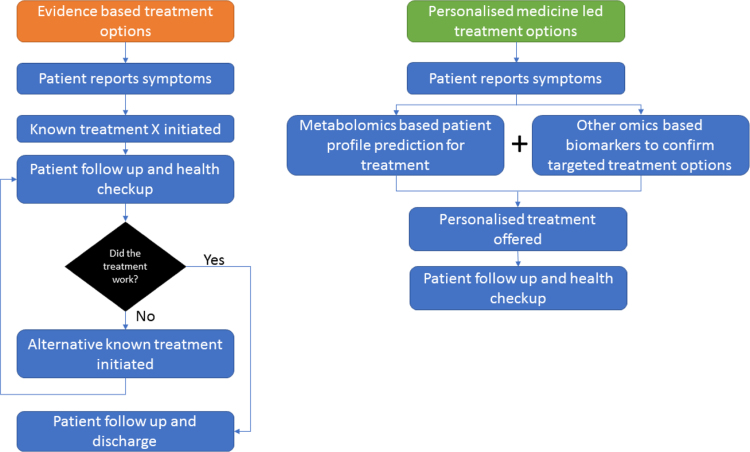
Flow diagram illustrating personalised medicine and highlighting the differences between Evidence-based versus Precision medicine-based approaches to disease treatment. As is clear the evidence-based approach is imprecise as it relies on the patient reporting progress to therapy. By contrast, precision medicine necessitates analytical measurements on the patient – typically from genetics (viz. SNPs) and metabolomics–and then using these to direct therapy.